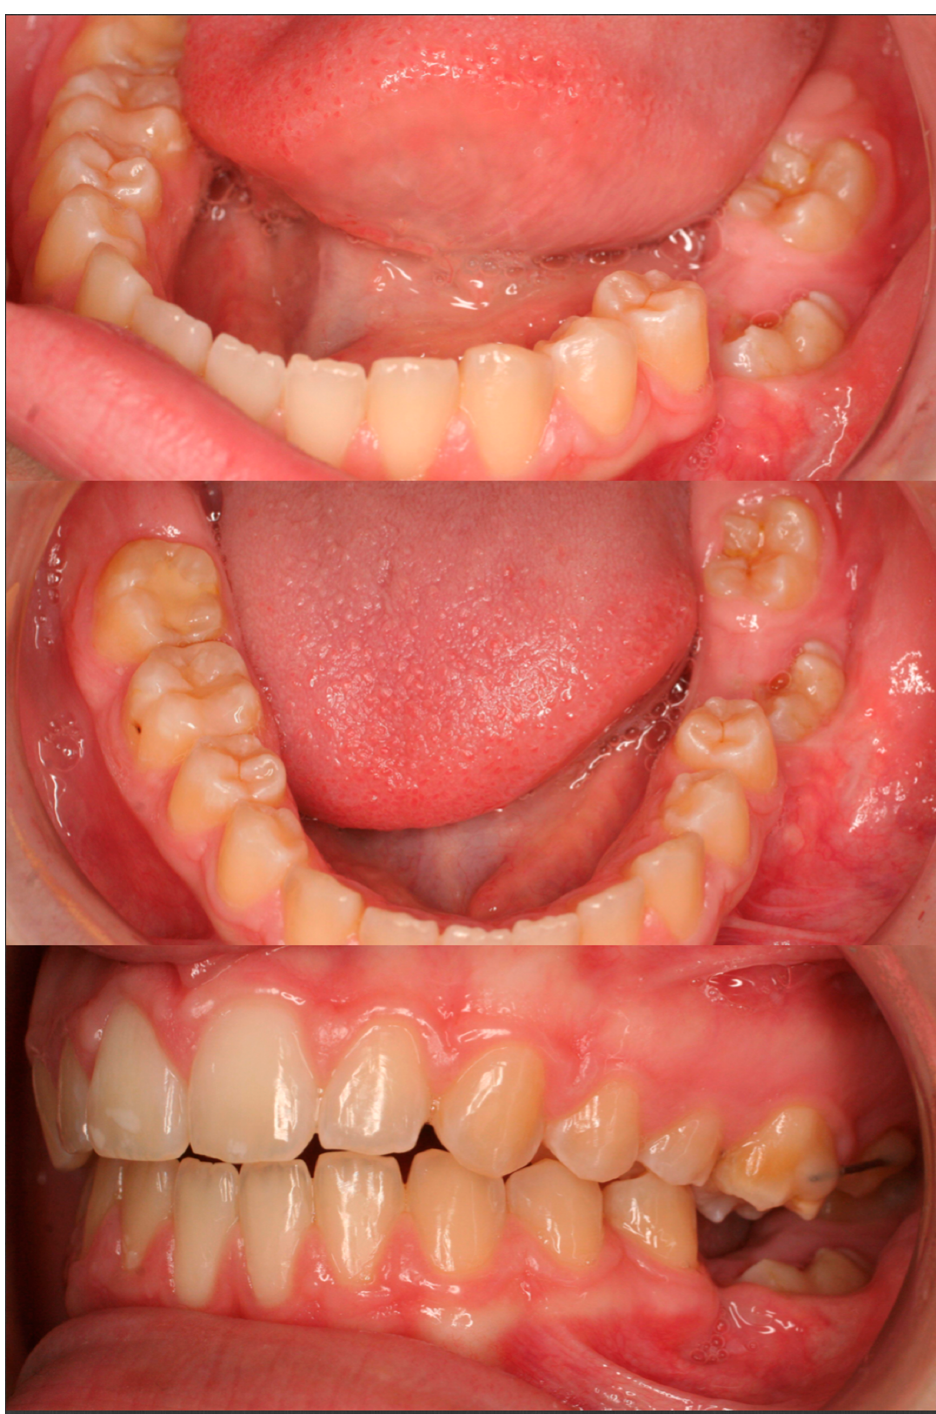
Figure 5. Immediately after debonding of the fixed orthodontic appliances of both dental arches. The mandibular left first molar was left to erupt spontaneously. Note that the maxillary molars are attached to one another via a stainless-steel wire in order to prevent further eruption of the first maxillary molar.